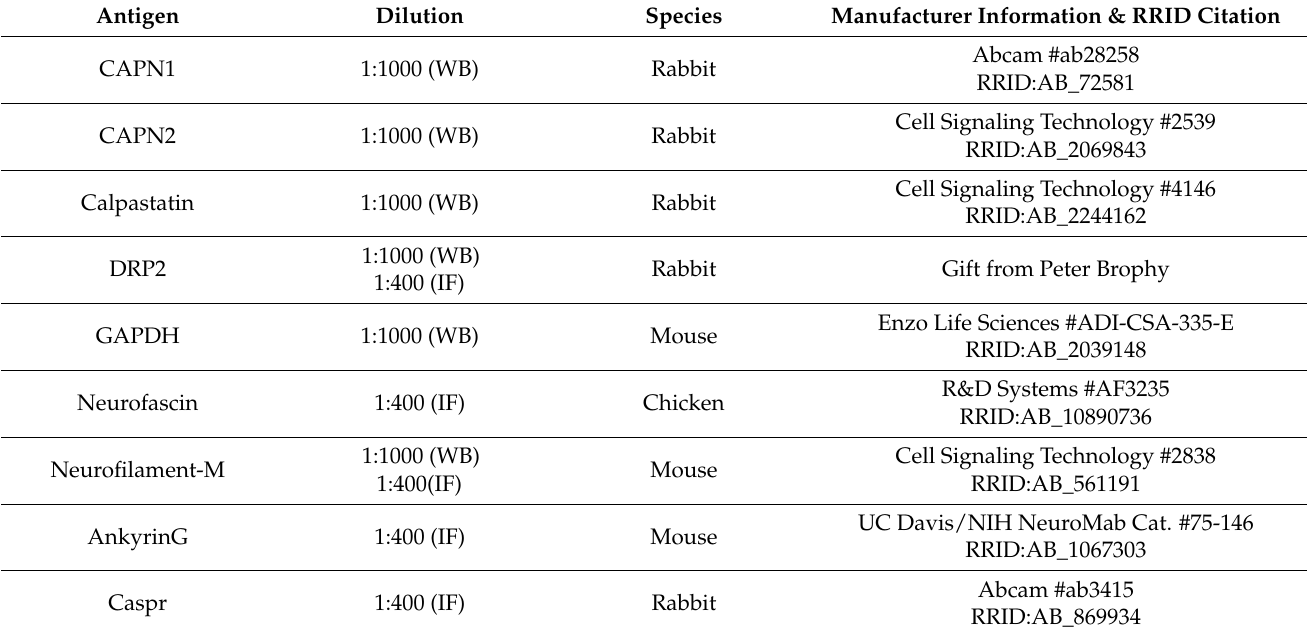
Table 1. Primary antibodies used for immunoblotting and/or immunofluorescent